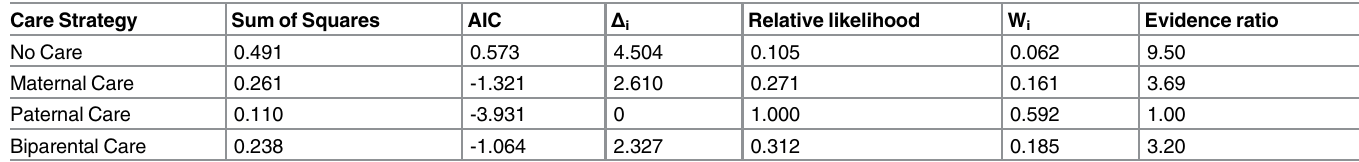
Table 7. Calculated likelihood that the four theropod dinosaurs Troodon formosus , Byronosaurus jaffei , Citipati osmolskae , and Machairasaurus philoceratops show each parental care strategy. Care Strategy Maternal Care Paternal Care Biparental Care